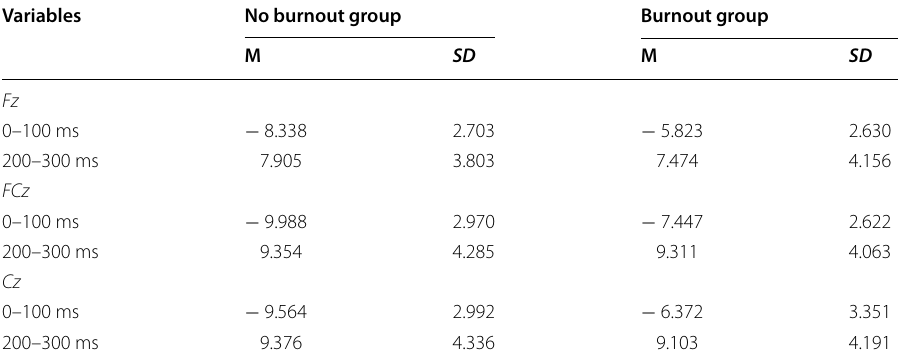
Table 5 ERN and early Pe of college athletes with and without burnout Variables